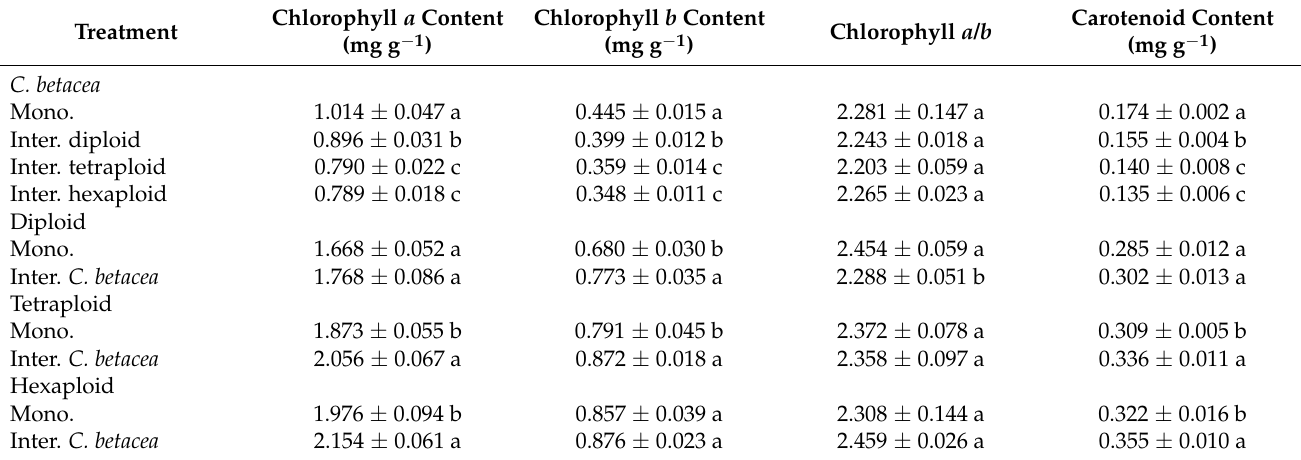
Values are means ± SD of three replicates. Different lowercase letters indicate significant differences among the treatments (Duncan’s multiple range test, p < 0.05). Mono. = monoculture; Inter. diploid = intercropped with diploid; Inter. tetraploid = intercropped with tetraploid; Inter. hexaploid = intercropped with hexaploid; Inter. C. betacea = intercropped with C. betacea